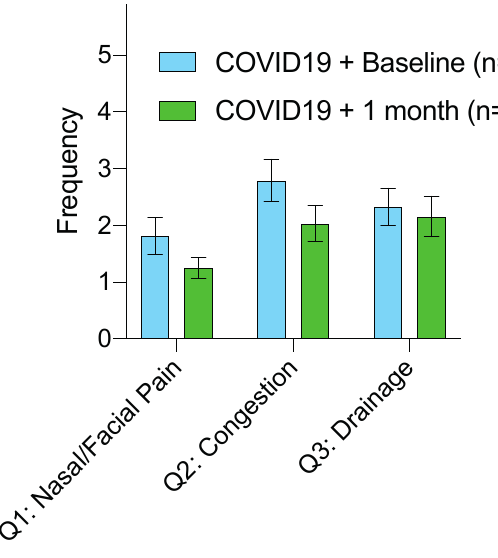
Figure S5. COVID-19 + Patients Reported Improved Olfactory Function at 1 month Compared to Baseline. There was a significant difference in self-reported smell symptoms in COVID-19 + patients at baseline (blue) compared to 1 month later (green). Error bars represent 95% confidence intervals. Questions are answered on a 5-point Likert scale (1=never, 2=rarely, 3=sometimes, 4=often, 5=always). Q4: Odors smell different than I remember. Q5: My smell has been good. Q6: My sense of smell has bothered me. Q7: It has been hard for me to smell. Q8: Food has smelled good. The scores for Questions 5 and 8 were inverted for